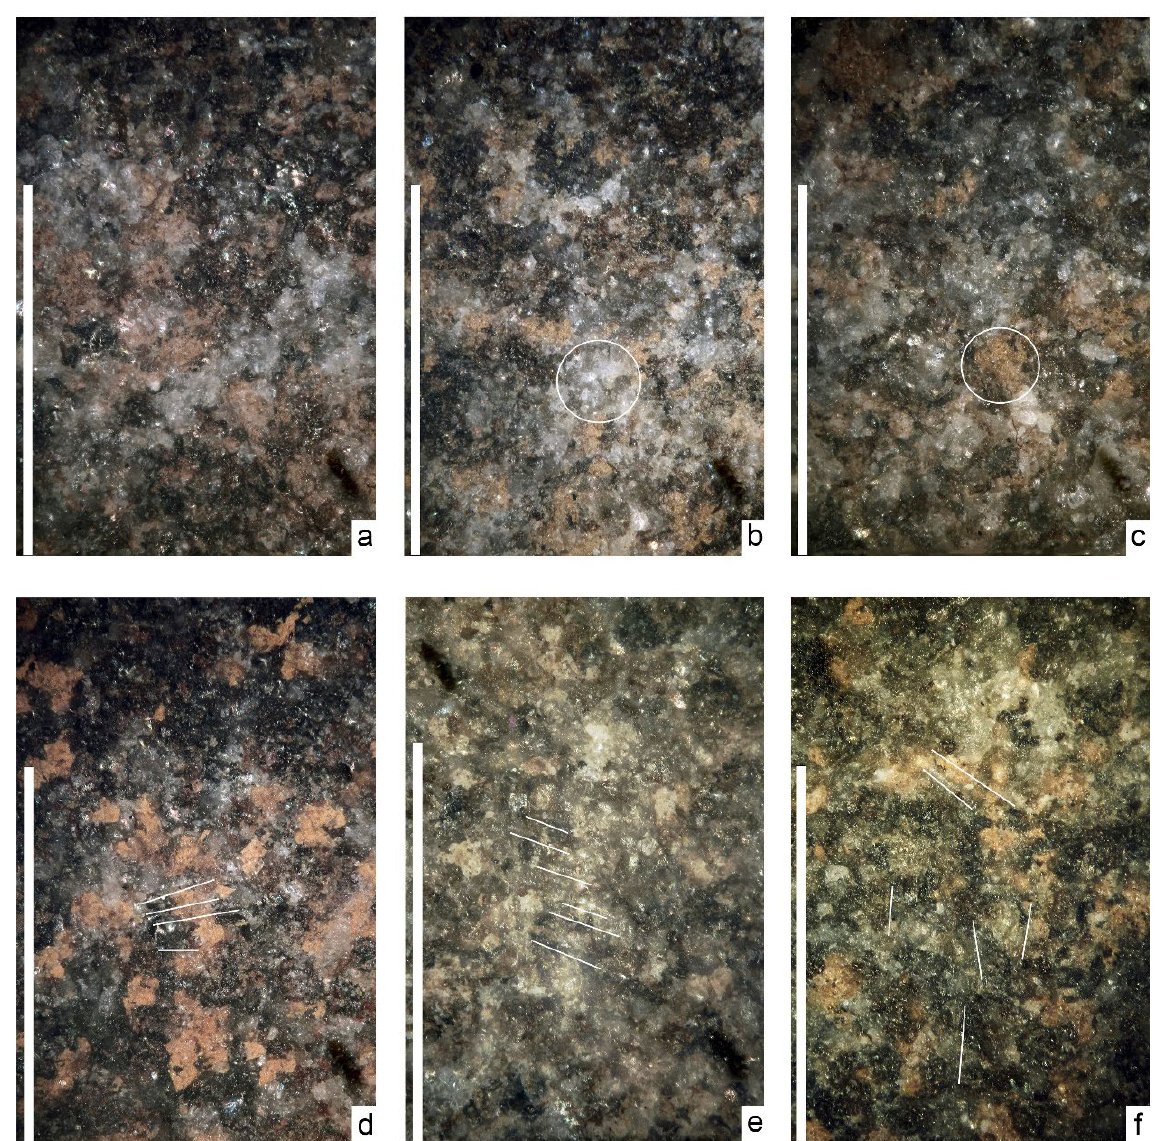
Figure 6. Microphoto of the surface of the lower grinding stone from the Kamennaya Balka II site (100×, scale bar = 1 mm): a - natural surface; b - surface with traces of technique of tool-making by pecking; c - surface with traces of percussion; d-f - working surface with linear use-wear